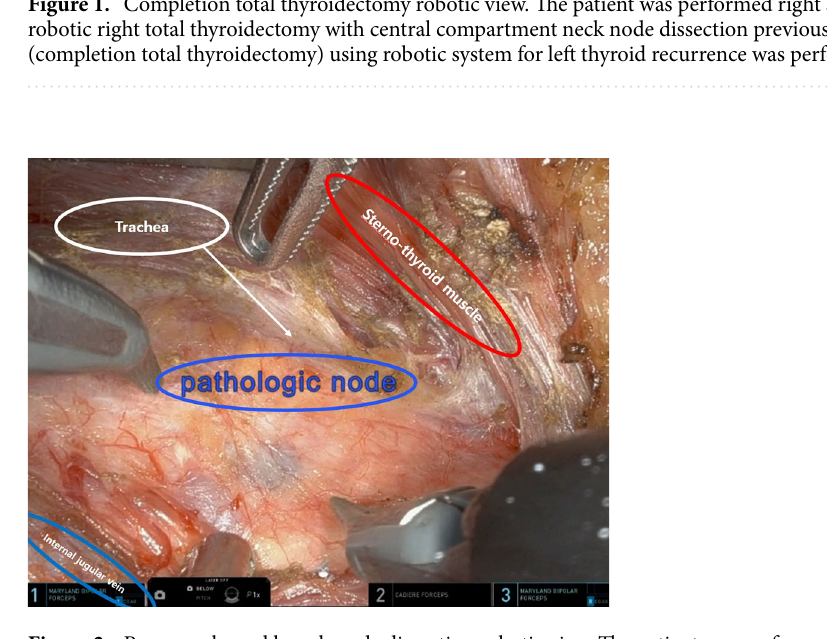
Figure 2. Para-esophageal lymph node dissection robotic view. The patient was performed left side approach robotic bilateral total thyroidectomy with central compartment neck node dissection and left modified radical neck node dissection previously. Re-do operation (para-esophageal lymph node dissection and right modified radical neck node dissection) using robotic system for right side para-esophageal lymph node and right lateral neck node recurrence was